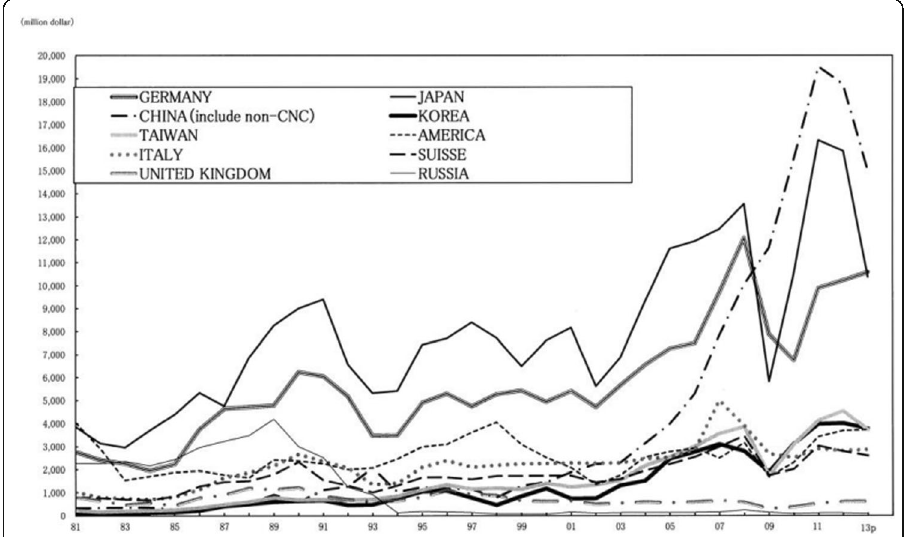
Fig. 8 Trend of machine tool production volume in major countries (1981 – 2013). Note: the Chinese